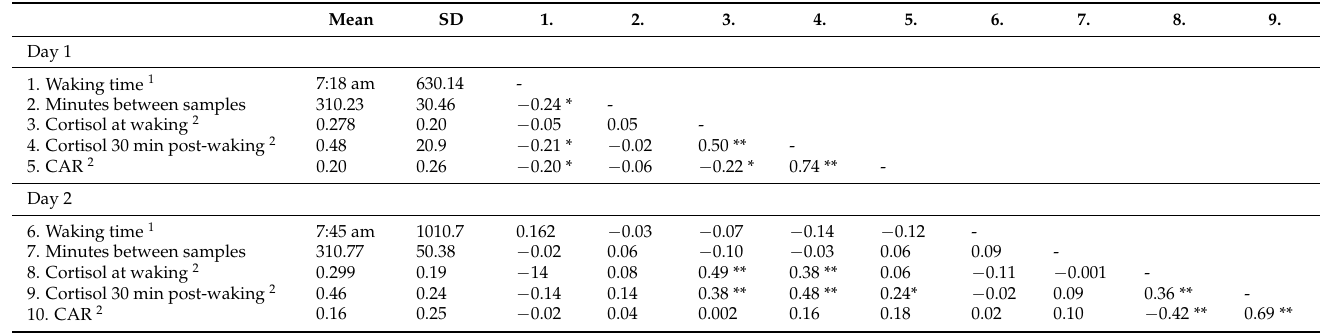
Table A1. Means, standard deviations, and correlations between cortisol